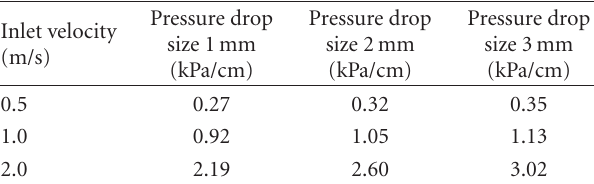
Table 3: Simulated pressure drop of di ff erent spacer